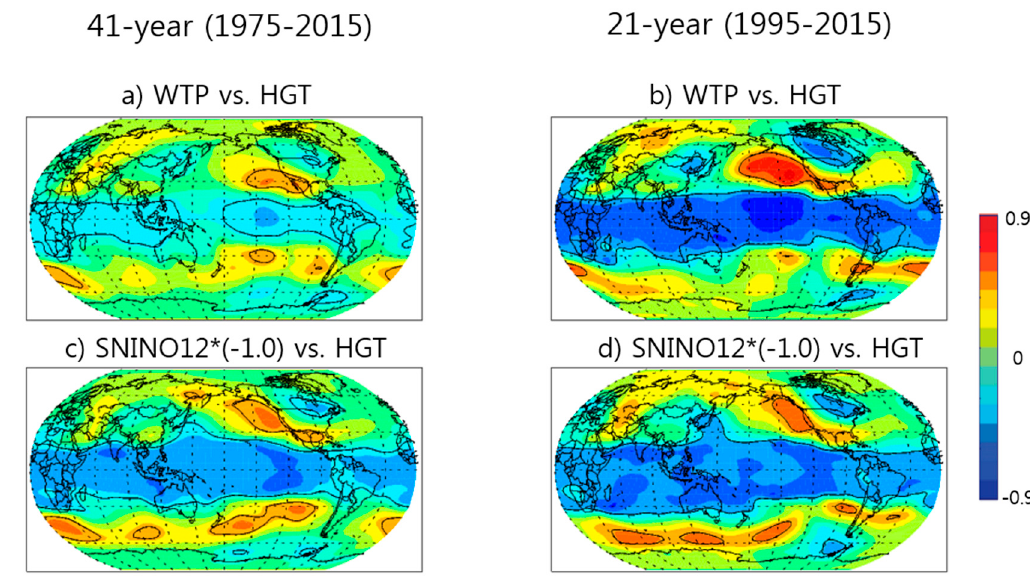
Figure 8. Forty-one-year correlation map of HGT with ( a ) WTP and ( b ) SNINO12 for Period 1 (1975–2015); ( c ), and ( d ) are the same but for Period 2 (1995–2015). SNINO12 values are multiplied by ( − 1.0). Black solid lines indicate statistical significance at the 95% confidence level.